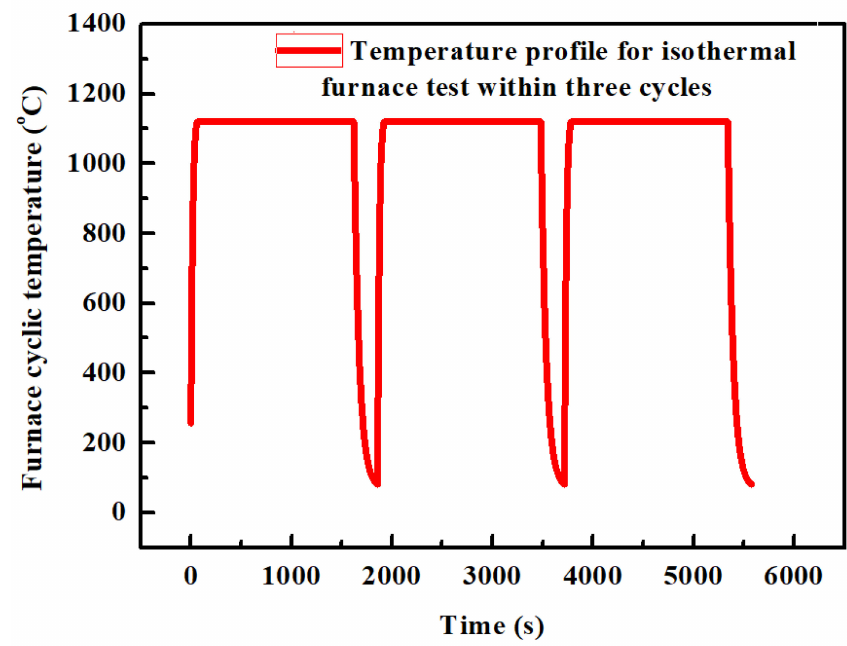
Figure 3. Temperature profile under isothermal furnace cycling